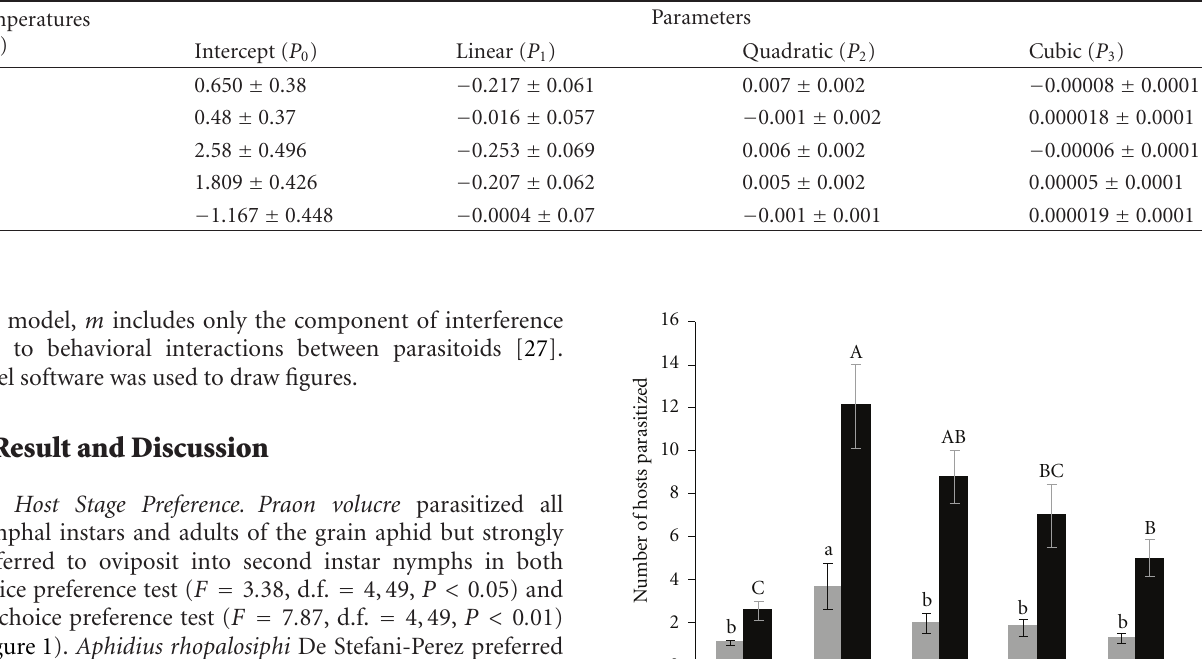
temperature changes. The ability of P. volucre to